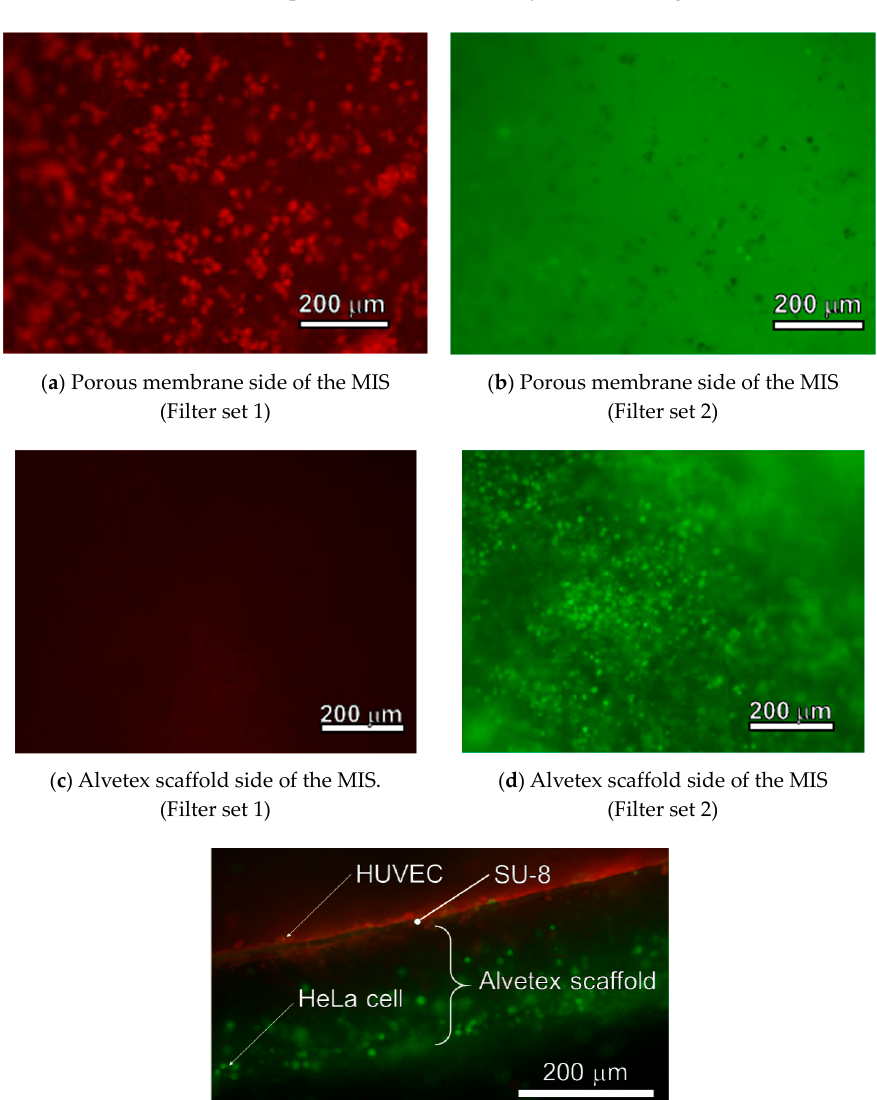
Figure 7. ( a ) HeLa cells attached to the surface of the Alvetex scaffold 4 days after seeding. ( b ) HeLa cells reached to the backside of the porous membrane 20 days after seeding.